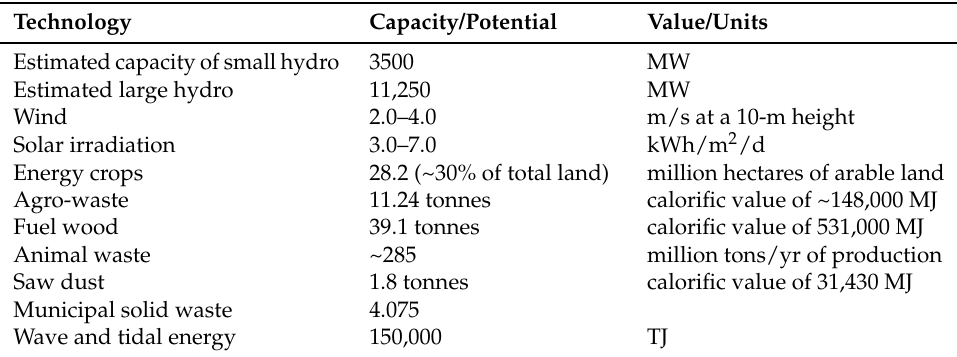
Table 3. Renewable energy potential in